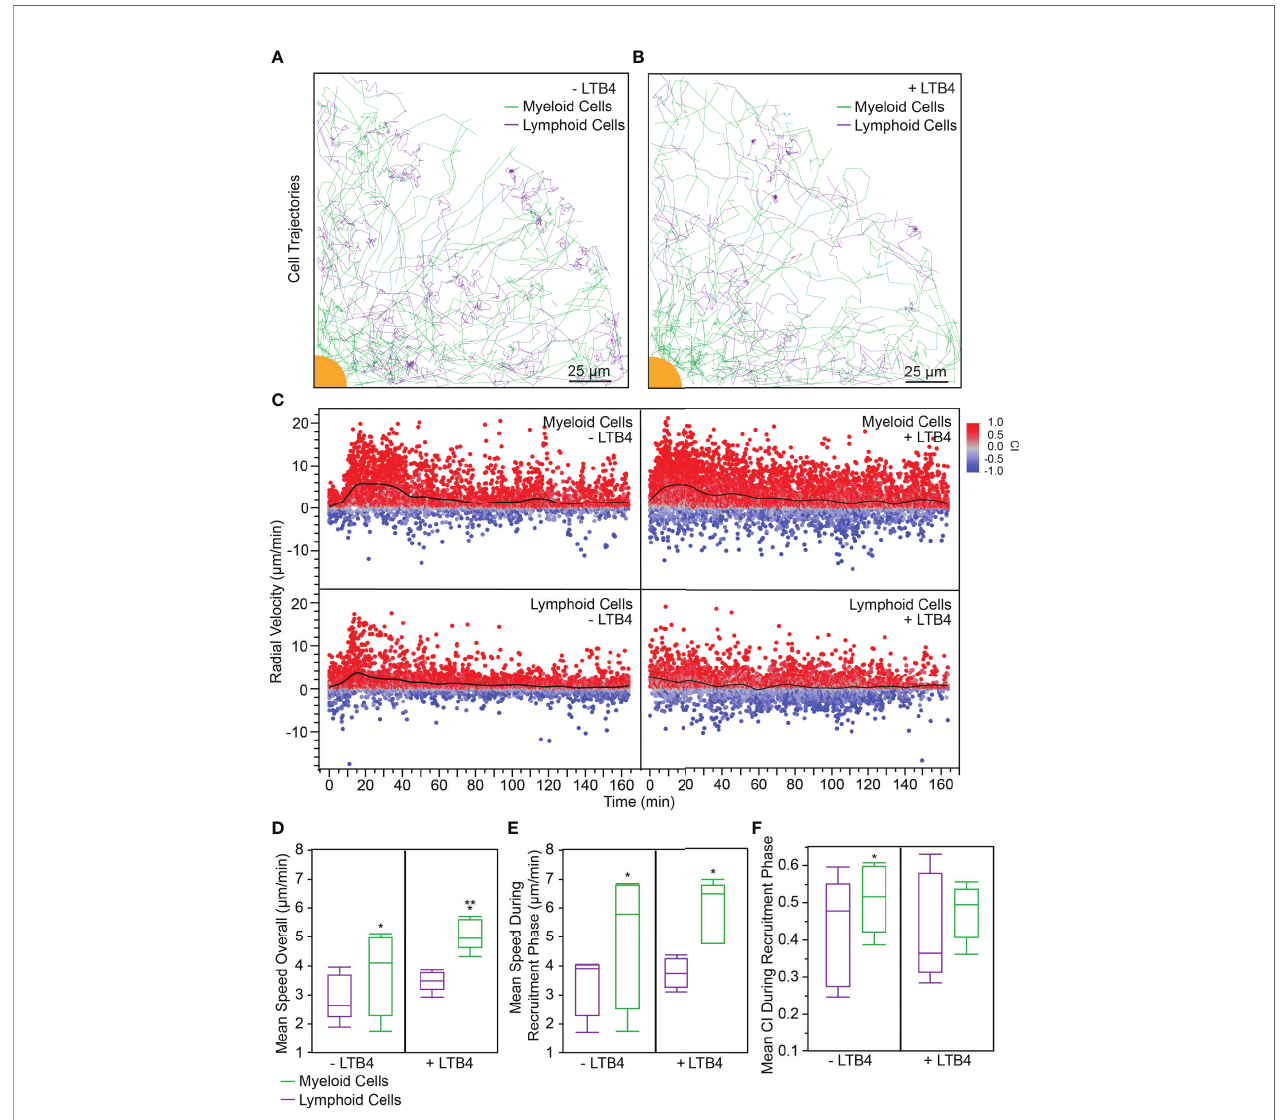
FIGURE 2 | (A) 20% of myeloid and lymphoid tracks (randomly selected) from a representative experiment are shown. In the absence of exogenous LTB 4 , myeloid cells followed more radial tracks toward the target. Interestingly, few lymphoid cell tracks came within the swarm. (scale bar: 25 µm) (B) 20% of myeloid and lymphoid tracks (randomly selected) from a representative experiment are shown. When exogenous LTB 4 was added to the system, myeloid cells followed less direct paths to the target, though a swarm still formed. Few lymphoid cells entered the swarm. (scale bar: 25 µm) (C) Myeloid cells without exogenous LTB 4 followed the expected swarming pattern with scouting (t = 0 – 15 min), recruitment (t = 15 – 45 min), and equilibrium (t > 45 min) phases. The recruitment phase had a signi fi cantly higher radial velocity than either the scouting or equilibrium phase (Anova, p < 0.0001). When exogenous LTB 4 was present, the scouting phase was not distinguishable, because the myeloid cells were already activated by the LTB 4 (Anova between t = 0 – 15 min and t = 15 – 45 min, a = 0.05). Interestingly, lymphoid cells had a small phase of recruitment toward the swarm, indicated by the increased radial velocity from 15 – 45 min (Anova between t = 0 – 15 min and t = 15 – 45 min, p < 0.05). When exogenous LTB 4 was present, this recruitment phase was not observed (Anova between t = 0 – 15 min and t = 15 – 45 min, a = 0.05). (D – F) . Statistical tests: *p < 0.05 for student t-test comparing myeloid to lymphoid cells within a given LTB 4 condition (either LTB − 4 or LTB + 4 ). **p < 0.05 for student t-test comparing the LTB − 4 to the LTB + 4 condition within a given cell type (either myeloid or lymphoid cells). (D) The mean speed of myeloid cells throughout the experiment was higher than that of lymphoid cells, regardless of the presence of exogenous LTB 4 ( LTB − 4 condition: 3.72 ± 1.41 µm/min and 2.90 ± 0.79 µm/min, for myeloid and lymphoid cells respectively, p = 0.04, N = 5. LTB + 4 condition: 5.08 ± 0.55 µm/min and 3.47 ± 0.35 µm/min, for myeloid and lymphoid cells respectively, p = 0.007, N = 5). Exogenous LTB 4 caused increased speed of myeloid cells but did not signi fi cantly impact lymphoid cell speed ( a = 0.05). (E) Similarly, the mean speed of myeloid cells during the recruitment phase of the experiment was higher than that of lymphoid cells, regardless of the presence of exogenous LTB 4 ( LTB − 4 condition: 4.89 ± 2.26 µm/min and 3.31 ± 1.02 µm/min, for myeloid and lymphoid cells respectively, p = 0.02, N = 5. LTB + 4 condition: 5.90 ± 1.05 µm/min and 3.75 ± 0.51 µm/min, for myeloid and lymphoid cells respectively, p = 0.005, N = 5). However, there was no signi fi cant difference between myeloid or lymphoid cell speed during the recruitment phase of the experiment between LTB + 4 and LTB − 4 conditions ( a = 0.05). (F) Without exogenous LTB 4 , myeloid cells had a signi fi cantly higher CI during the recruitment phase of the swarm compared to lymphoid cells (0.51 ± 0.09 and 0.43 ± 0.14, respectively, p = 0.04, N = 5). There was no signi fi cant difference between myeloid and lymphoid cells with exogenous LTB 4 added (0.48 ± 0.07 and 0.43 ± 0.14, respectively, a = 0.05, N =